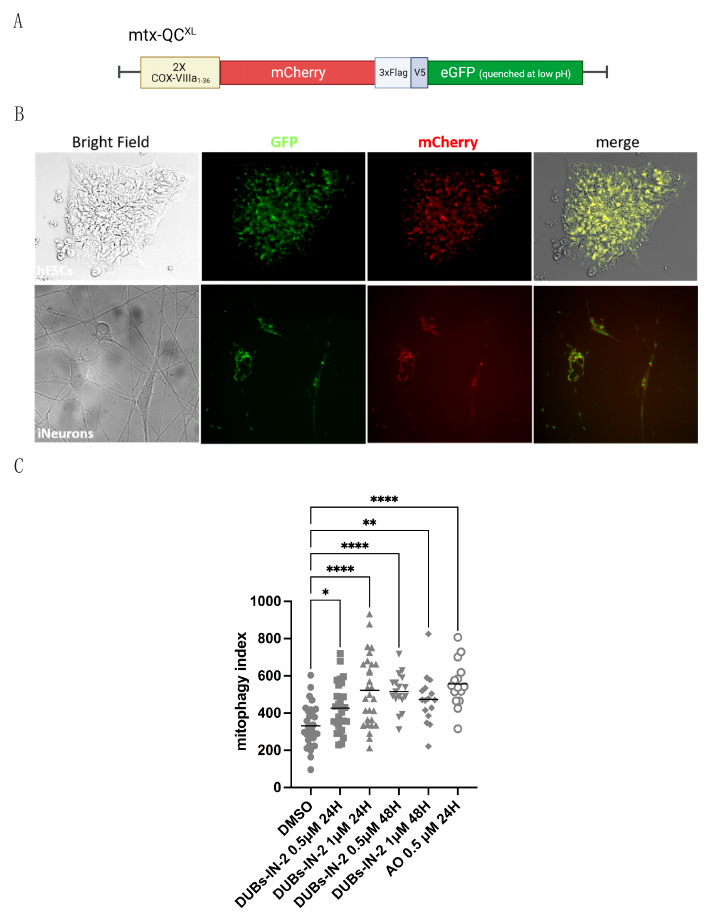
Figure 4. ( A ) Graphical representation of the mito-QC construct (mtx-QC XL ). A tandem mCherry–GFP tag is targeted to the IMM via mitochondrial targeting sequence of the Cytochrome c oxidase